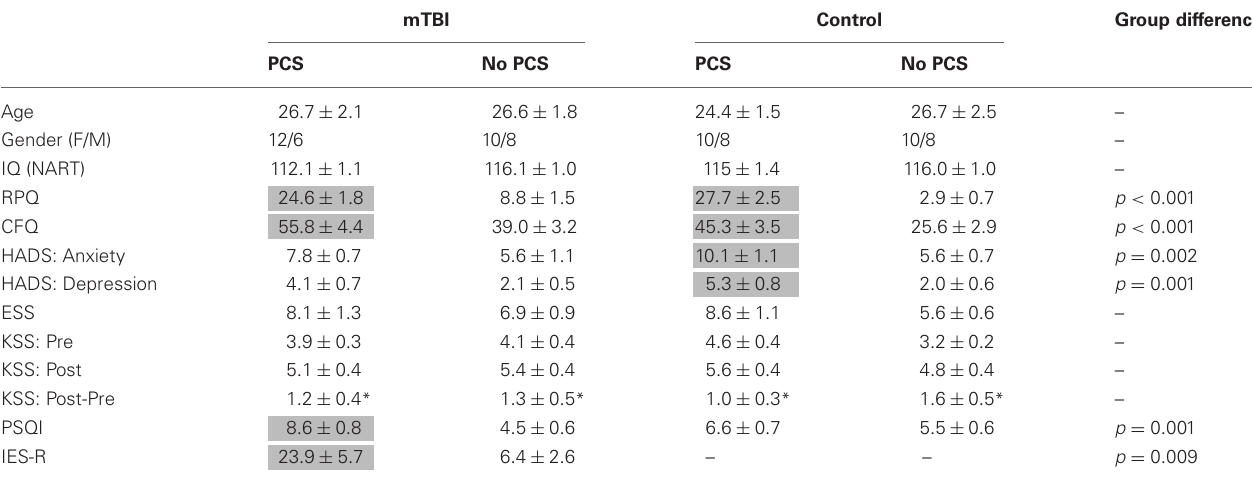
Table 1 | Demographic and questionnaire